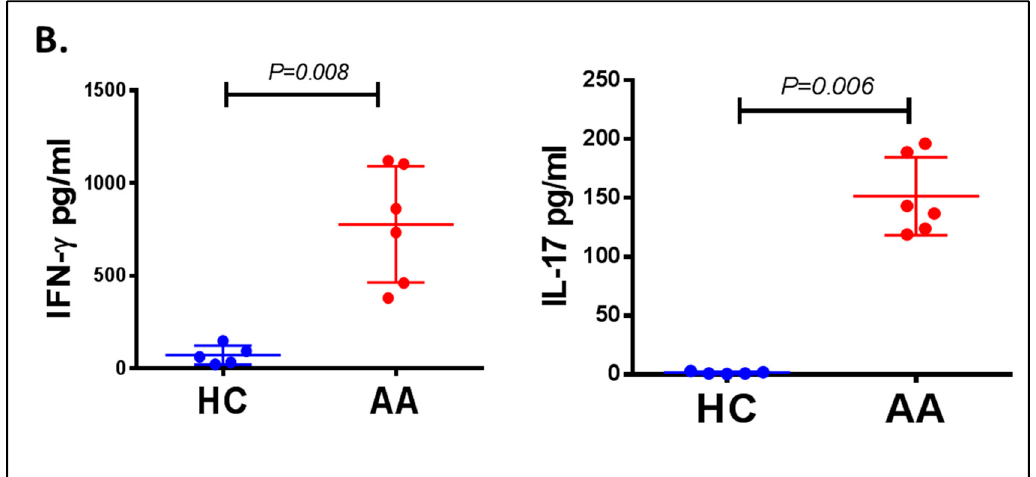
Figure 4. Inflammatory T cell subsets in AA. ( A ) Frequency of CD4+ and CD8+ T cell subsets of CD3+ lymphocytes and their subsets were investigated by flow-cytomteric analysis of PMBCs isolated from AA patients or HC. The CD4+ T cell pool and its inflammatory subsets (Th1 and Th17) were increased in AA compared to HC. The NKG2D+ subset of CD8+ T cells were also increased in AA. ( B ) The production of IFN- γ and IL-17 cytokines by PBMC in AA patients is significantly higher than HC upon activation with ionomycin/PMA.